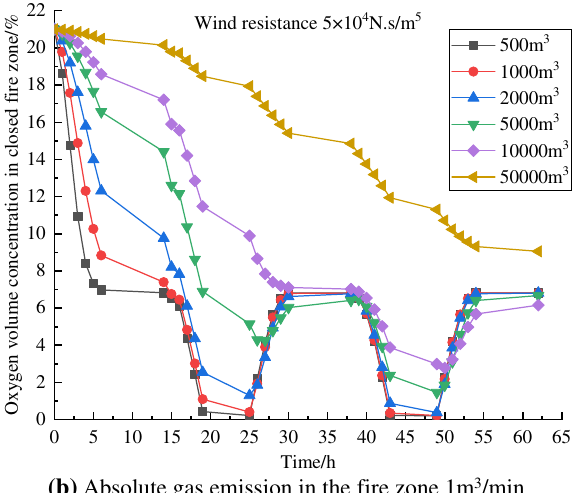
(b) Absolute gas emission in the fire zone 1m 3 /min Fig. 8 Different gas emission, different fire area volume, wind resistance, and the relationship between oxygen concentration and time in the fire zone after the completion of sealing at